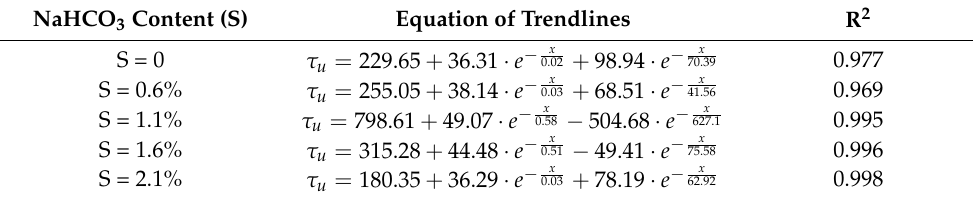
Table 5. Equation of trendlines of shear strength versus the number of FTCs at a confining pressure of 200 kPa.